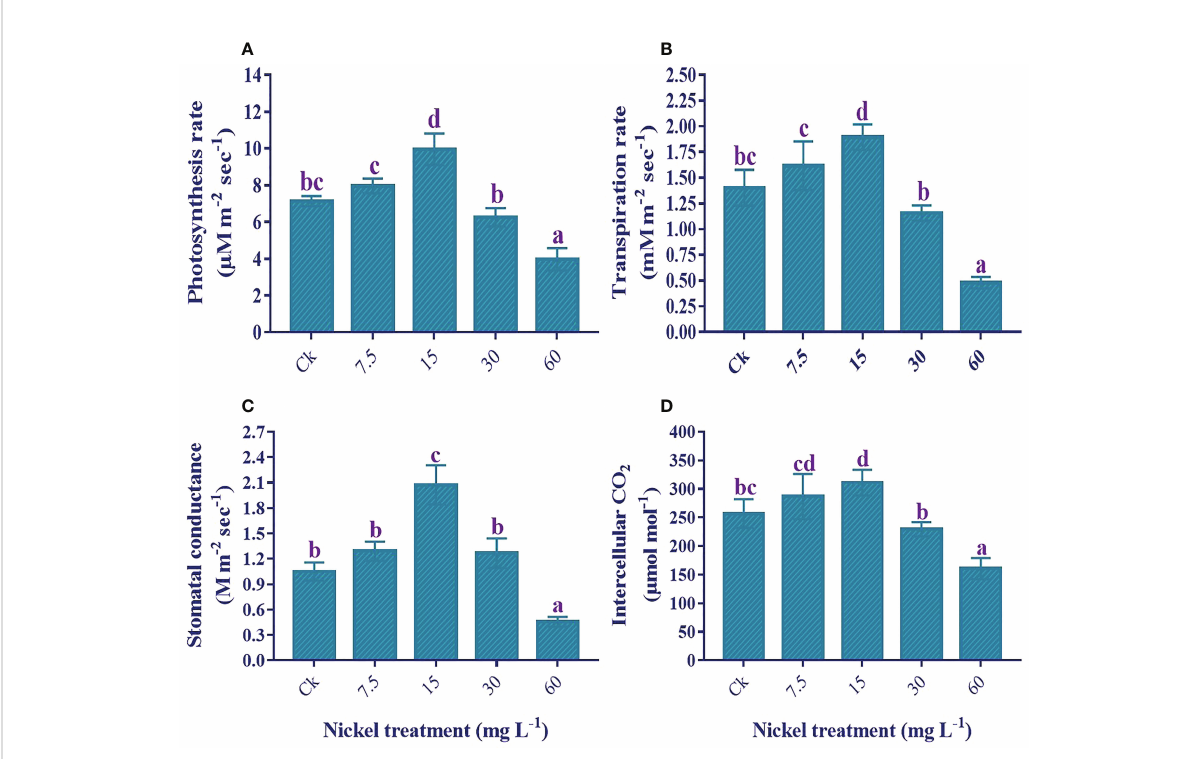
FIGURE 4 Effect of different Ni treatments on gaseous exchange elements in the leaf of sweetpotato; (A) photosynthetic rate (Pn), (B) transpiration rate (Tr), (C) stomatal conductance (Gs), and (D) Intercellular CO 2 (Ci). According to the Duncan test, different letters indicate a signi fi cant difference ( p < 0.05) among the fi ve treatments. The error bars represent the mean ±